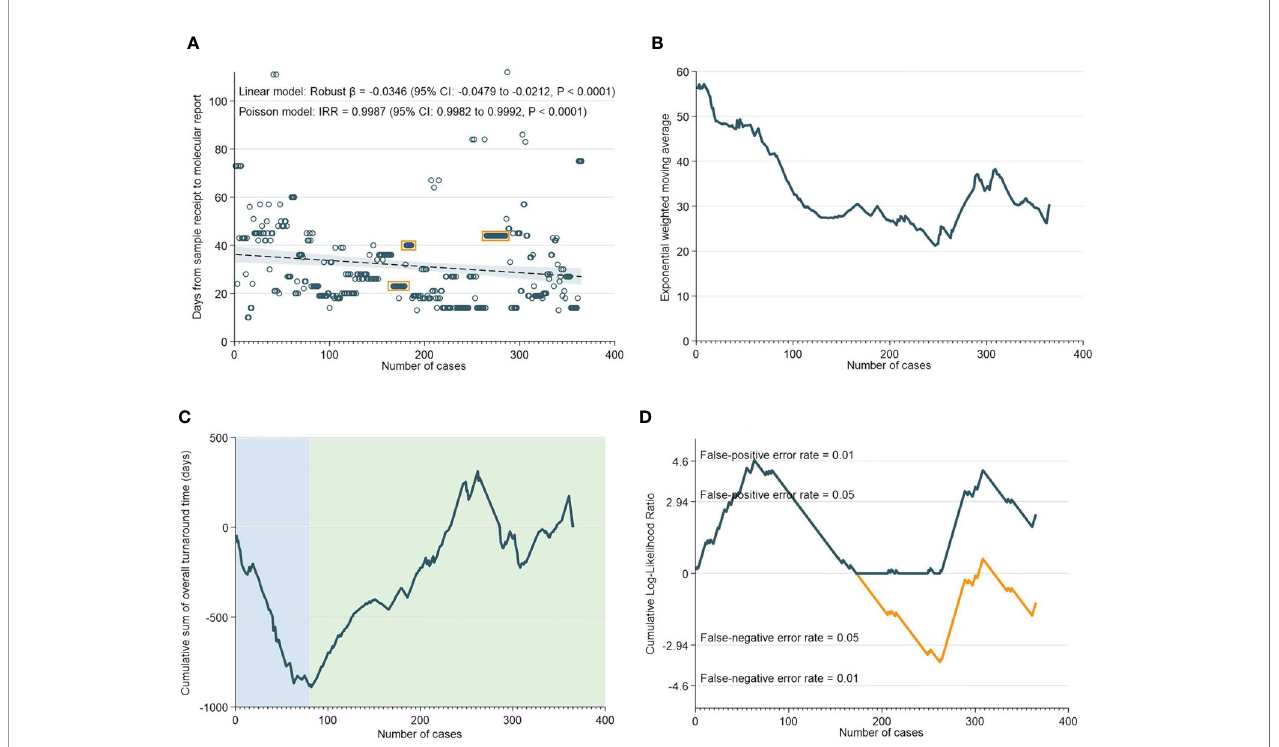
FIGURE 1 | Overall Turnaround Time. (A) Scatter and regression fi t of overall turnaround vs case load. (B) Exponential weighted moving average of overall turnaround time. (C) CUSUM of overall turnaround time. (D) CUSUM log-likelihood ratio chart for overall turnaround time > 3